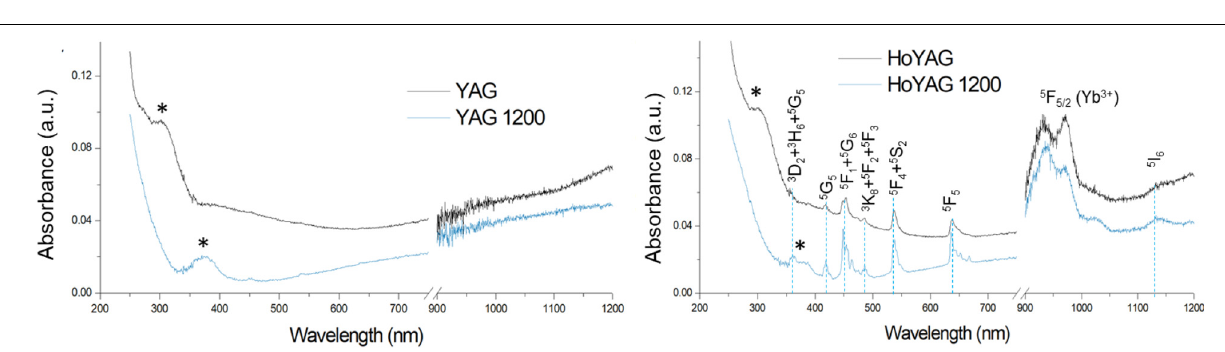
FIGURE 2 | SEM micrographs at two different magnifications of HoYAG sample annealed at 1200 ◦ C. Inset: Particle size distribution obtained by counting particles from SEM images (250 nanoparticles).